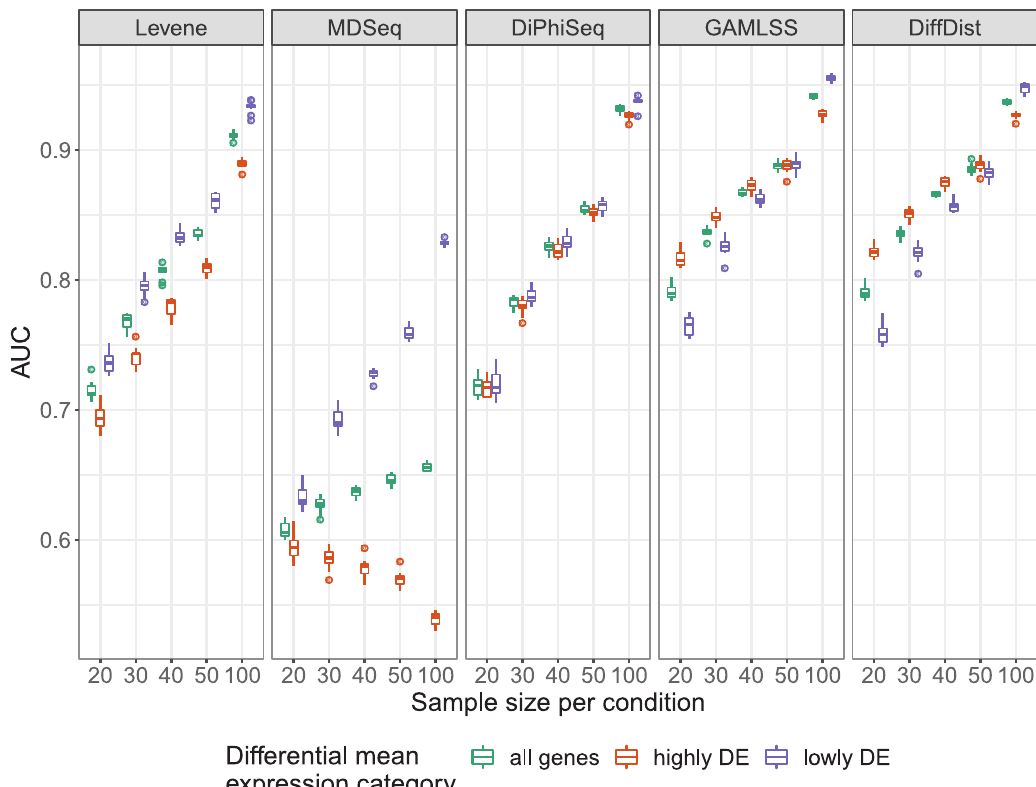
Fig 1. Ability to identify differentially dispersed genes. The performances of Levene’s test, MDSeq, DiPhiSeq, GAMLSS and DiffDist for differential dispersion detection in gene expression data, as measured by the area under the ROC curve (AUC), were assessed using 10 replicates of simulated datasets composed of highly and lowly differentially expressed genes between two sample populations of equal size.